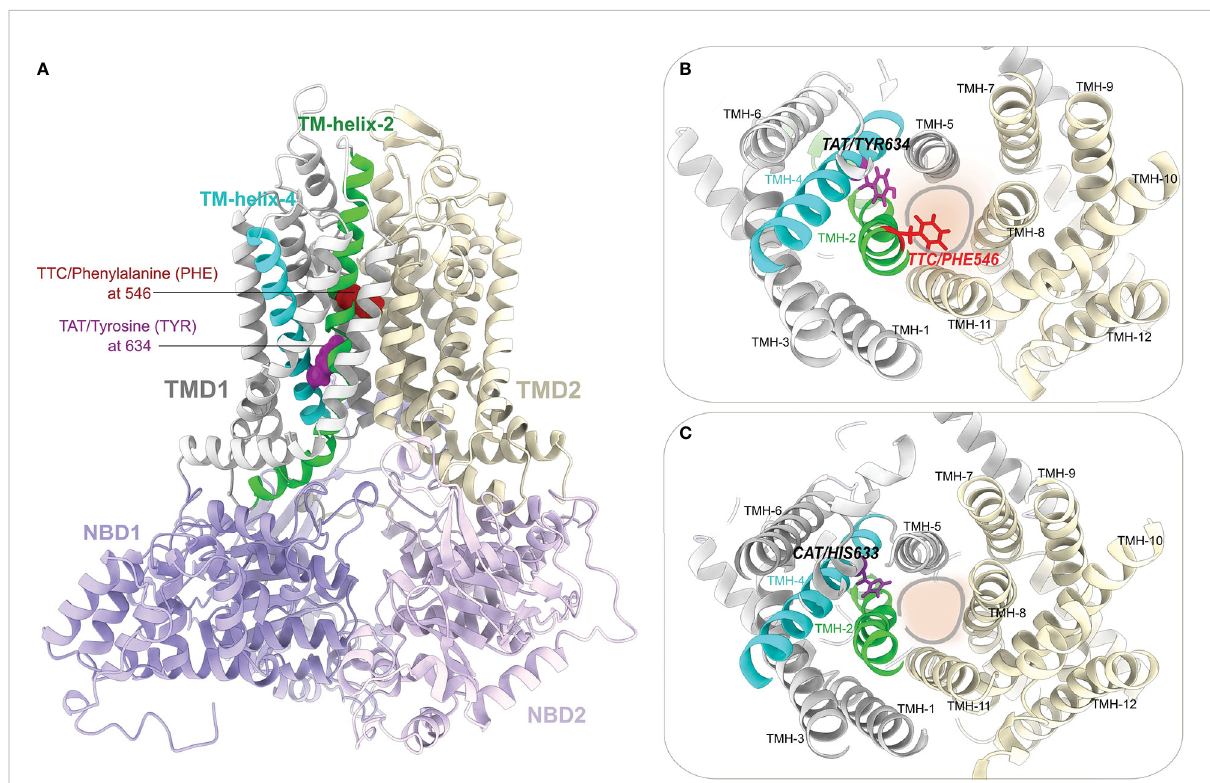
FIGURE 5 Predicted structural model of the LR34 protein. (A) Ribbon representation of the structural model of full-length LR34- generated using RoseTTAFold. The LR34- phenylalanine (PHE 546) located in transmembrane helix-2 (TMH-2), and tyrosine (TYR634) residues located in TMH-4 are displayed as red and magenta colored spheres, respectively. The two transmembrane domains (TMD1 and TMD2) and two nucleotide- binding domains (NBD1 and NBD2) are highlighted and labeled. (B) A view from the top (periplasmic) side of the LR34- model shows the arrangement of 12 transmembrane helixes in TMD1 (TMH-1 to 6) and TMD2 (TMH-7 to 12). The PHE546 and TYR634 residues at TMH-2 and TMH-4 are located close to the substrate binding sites/channel (marked by a circle). (C) Top (periplasmic) view of LR34+ with its histidine residue substitution at 633 (HIS633) in TMH-4 and deletion of PHE546 in